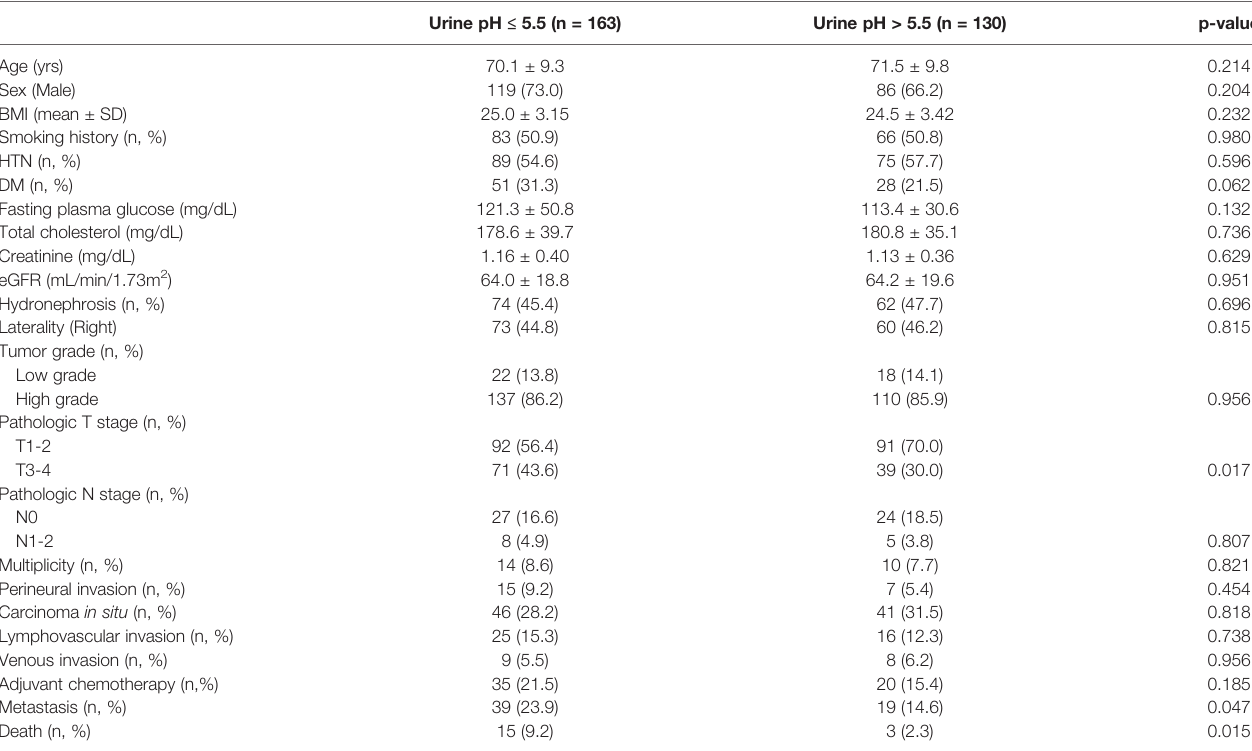
TABLE 3 | Comparison of low ( ≤ 5.5) and high (> 5.5) urine pH